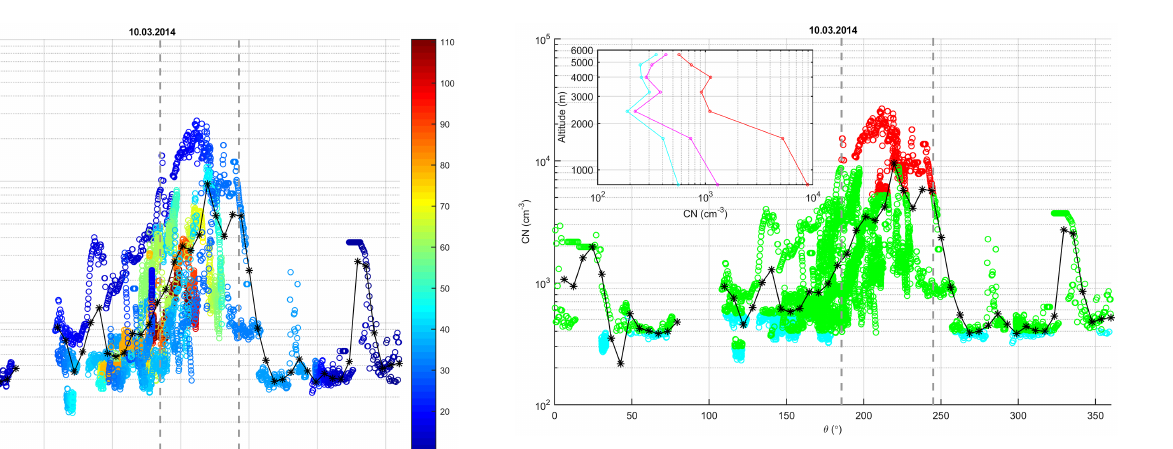
Figure 4. The same as Fig. 3, with the colouring representing the plume classification for 10 March 2014. The green-coloured dots represent unclassified points, red is for plume, and cyan is for back- ground conditions. The inset shows the median (cyan) and the 25% (blue) and 90% (red) percentiles profiles of CN